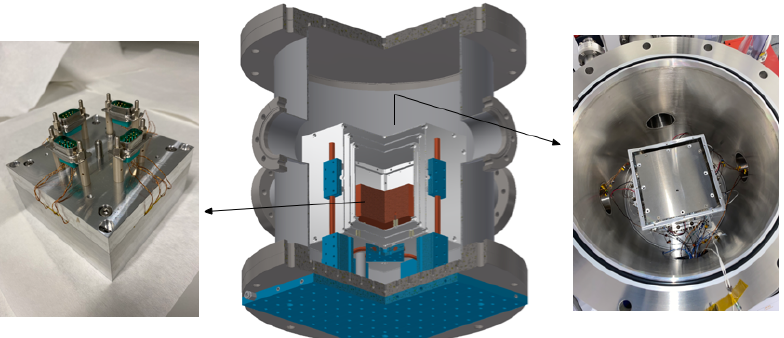
Figure 1. ( Center ): Vacuum chamber (dark gray) and thermal shields (light gray) drawing. The aluminium block where the sensors are placed is the central element, colored in brown. In blue, the water-cooled breadboard and heat pies used to extract the heat of the Peltier elements can be seen. ( Left ): Picture of the aluminium block hosting the sensors. ( Right ): Top view of the inside of the vacuum